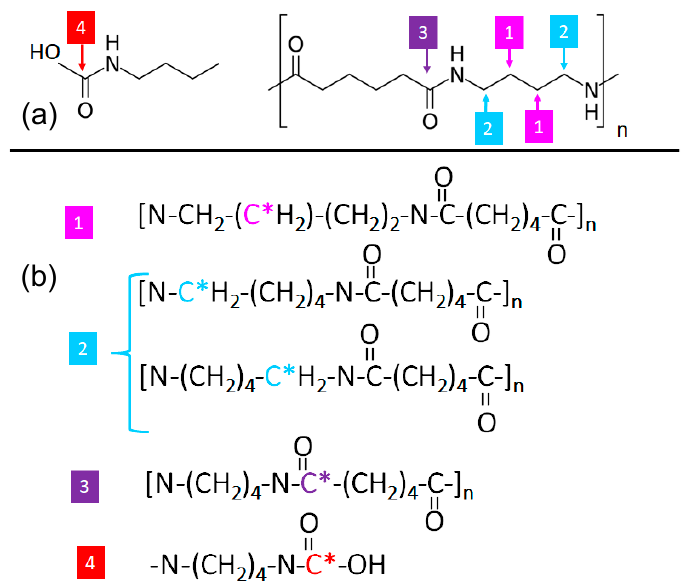
Figure 11. The chemical environment of C atoms in a nylon 66 structure. The C positions are numbered ( a ) in the schematic with respect to ( b ) their representative neighbors.